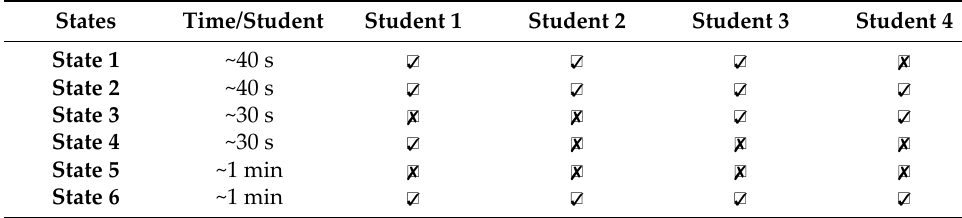
Table 3. Time slots for student attendance.